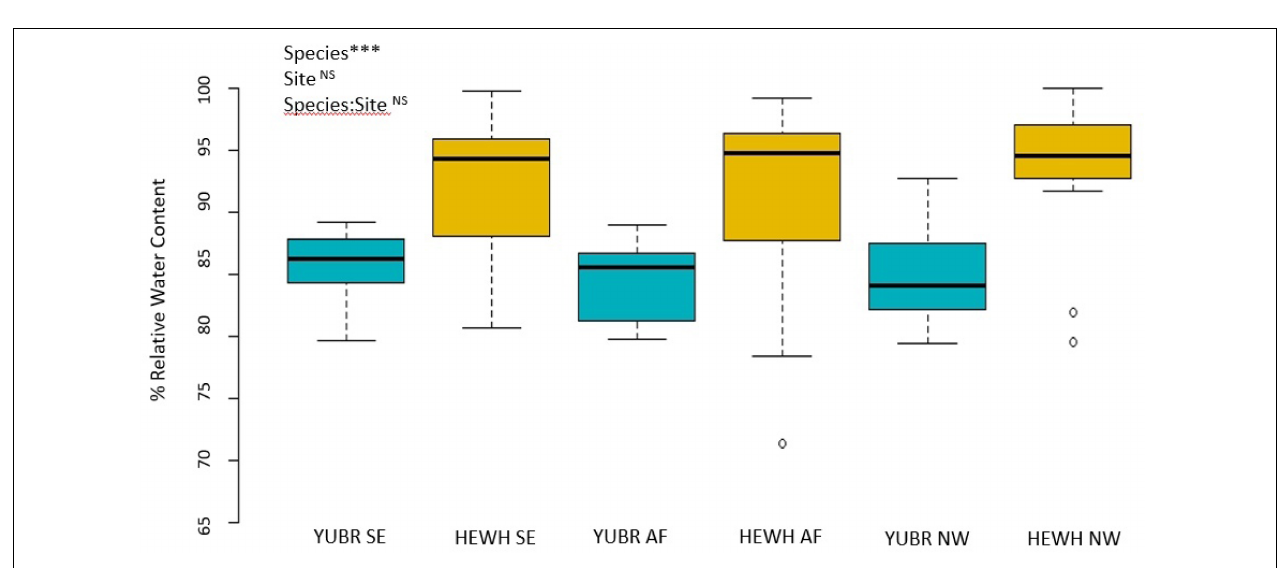
FIGURE 3 | Stomatal conductance ( g s ) varied significantly across species and sites. Different letters denote statistically significant differences across species and sites ( p < 0.05) by two -way ANOVA followed by a Tukey-Kramer post hoc test. YUBR = Y. brevifolia ; HEWH = H. whipplei ; SE, south-eastern slope; AF, alluvial fan; NW, north-western slope. n = 23–25 leaves per species per site. *** p < 0.001; NS p > 0.05.